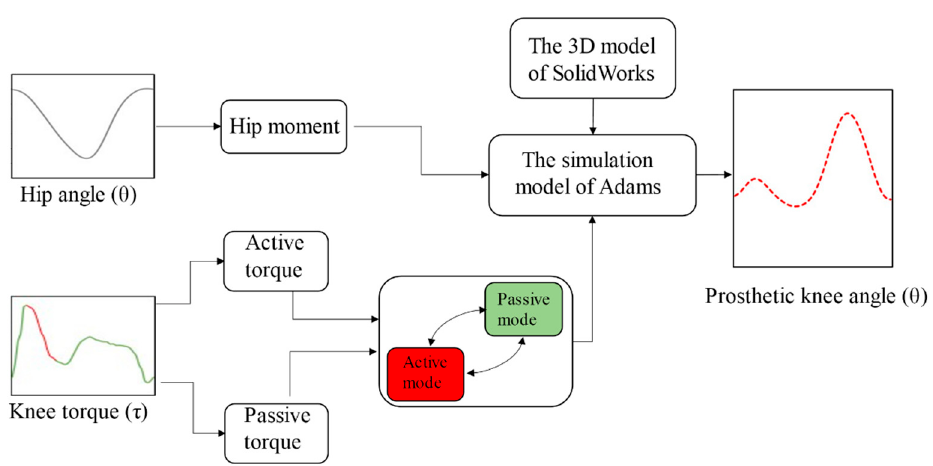
Figure 11. The knee angle acquirement scheme.